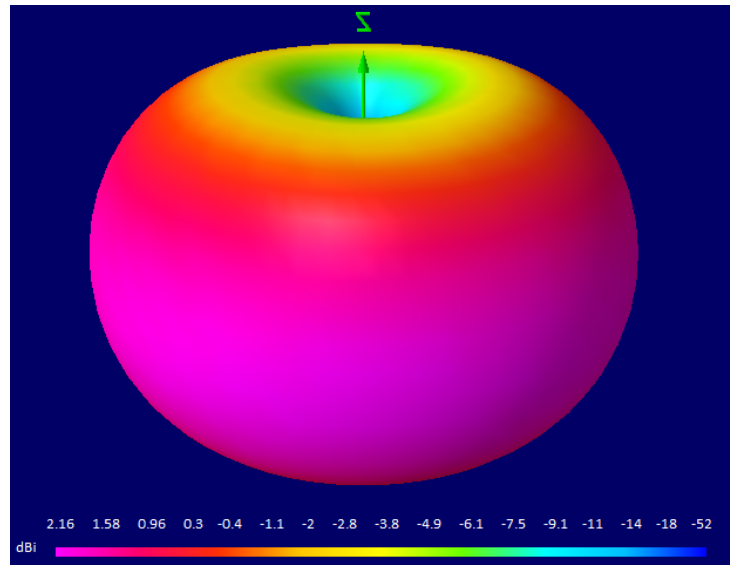
Figure A1. XBee antenna lobe. As illustrated in Figure A2, when the aircraft is at a higher height and close to the BS (overlapping antennas), the antennas provide low gains. Additionally, when they gain horizontal distance,the main free Fresnel zone changes such that the antenna gain increases.